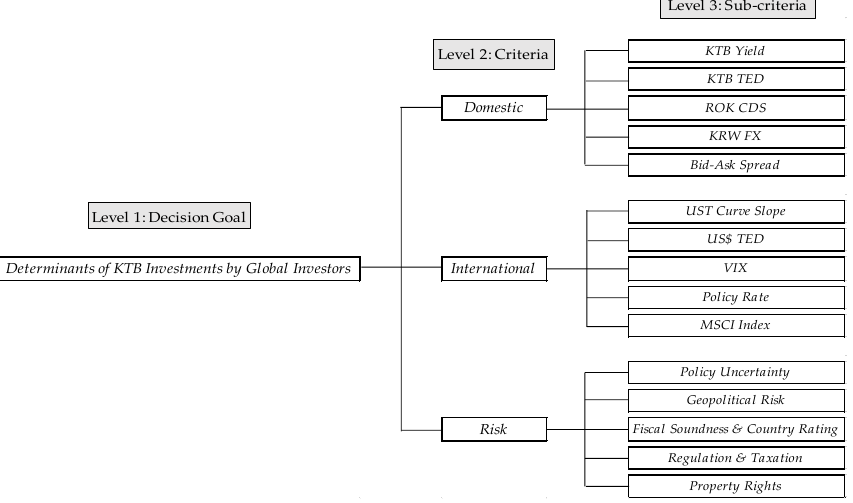
Figure 2 . Hierarchical structure and composition of evaluation criteria. Figure 2. Hierarchical structure and composition of evaluation